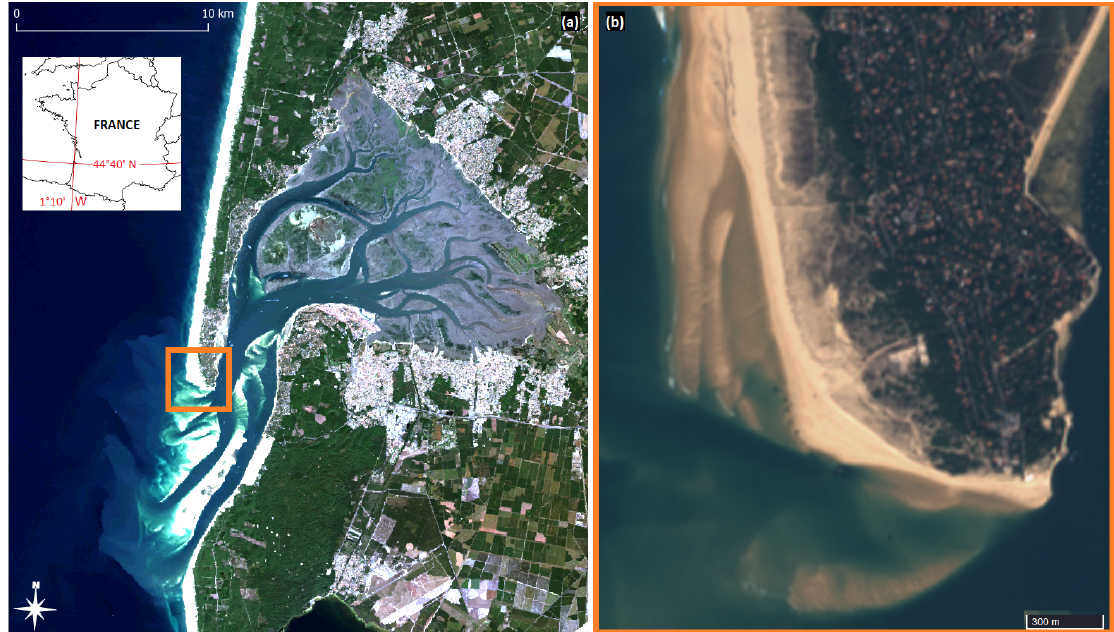
Figure 1. Satellite images of the study area on 26 September 2018. ( a ) Landsat image of the Cap Ferret barrier-spit and of the Bay of Arcachon. ( b ) Sentinel image of the surveyed beach and intertidal bars at the spit’s southern